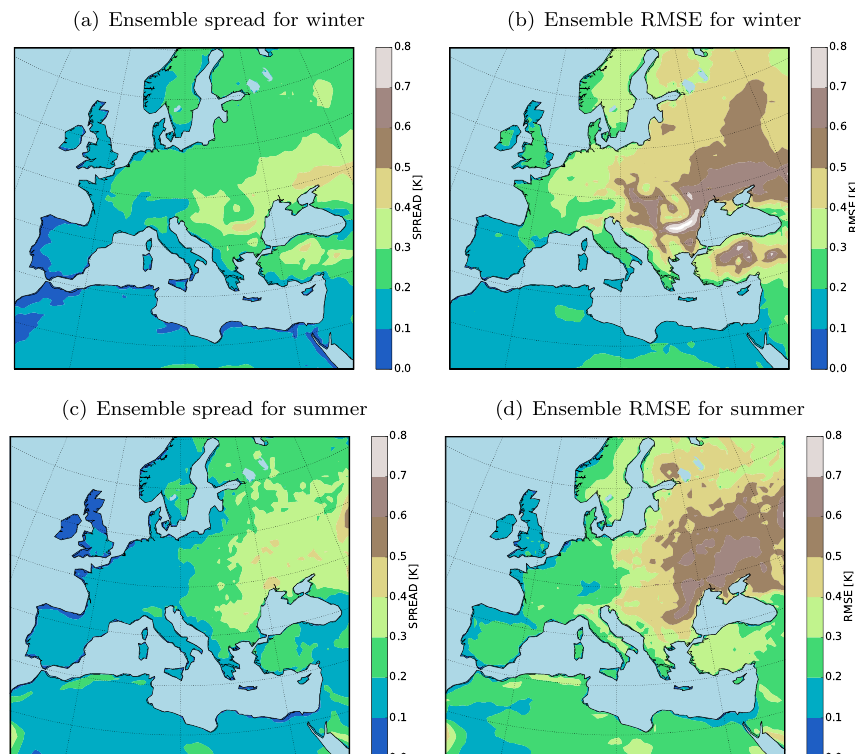
Figure 7. 36-year ensemble spread and RMSE for the seasonal mean of 2m temperature